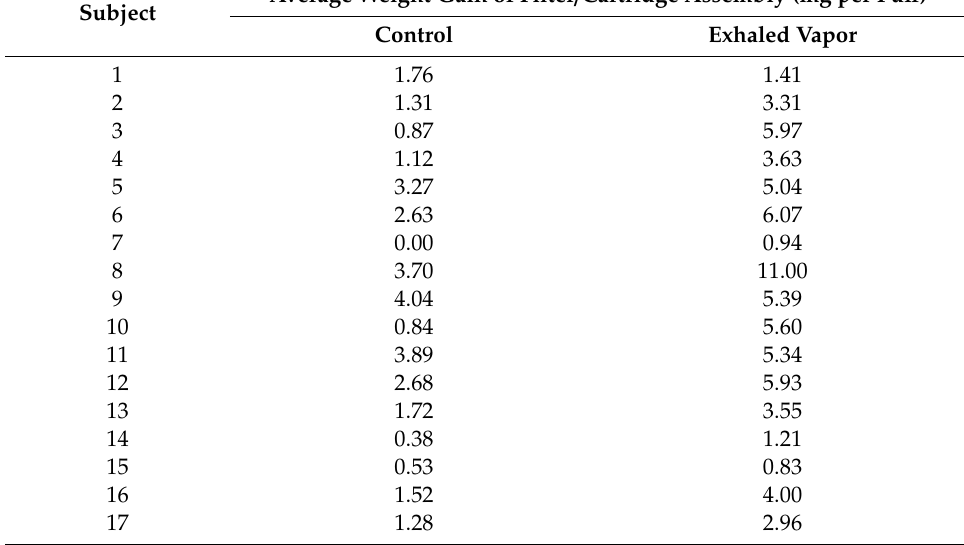
Table 2. Average mass gain of the trapping device for individual subjects for control breath (‘control’) or e-cigarette vapor exhalations (‘exhaled vapor’).